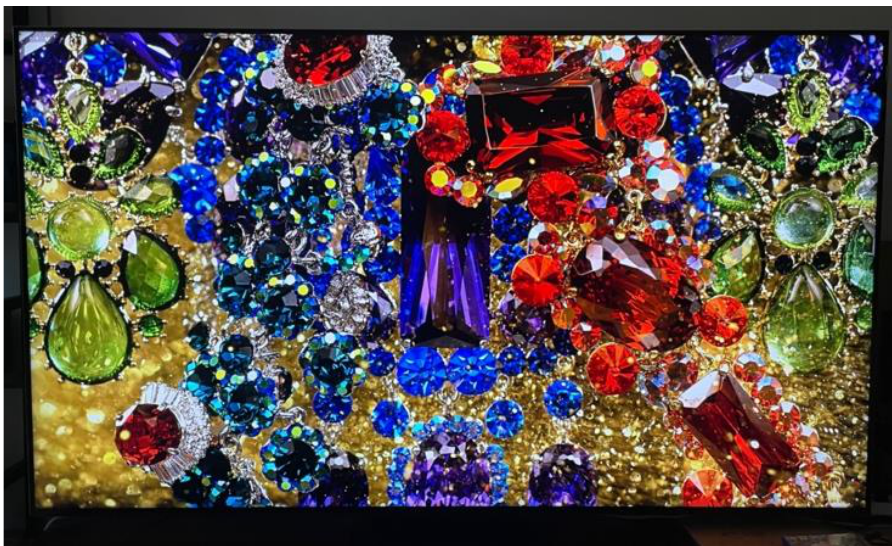
Figure 10. Photograph of the fabricated 85-inch UHD HDR single X-wire AM mini-LED BLU-based LCD display panel.